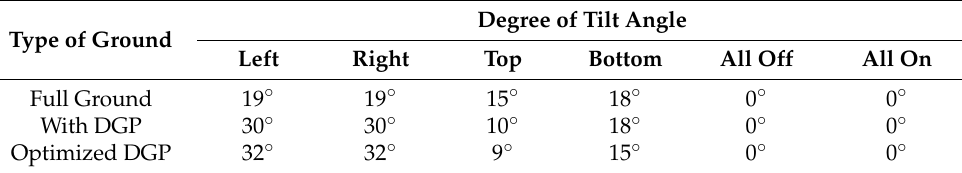
Table 2. Angle tilting comparison for different types of ground planes (simulated).